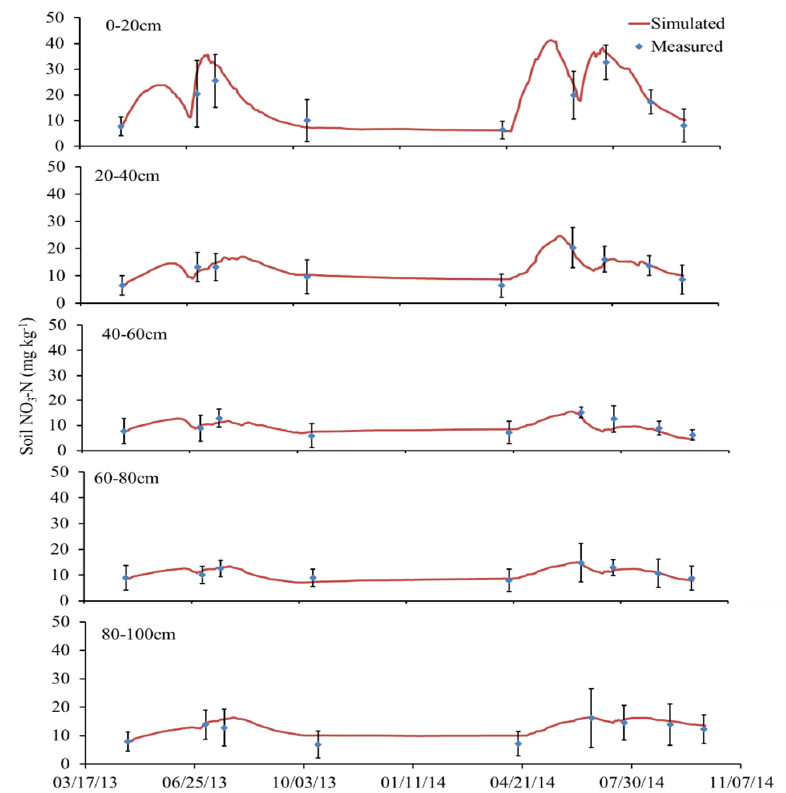
Figure 2. Comparison of simulated and measured soil nitrate concentration at different depths under N312 treatment in loamy clay soil.